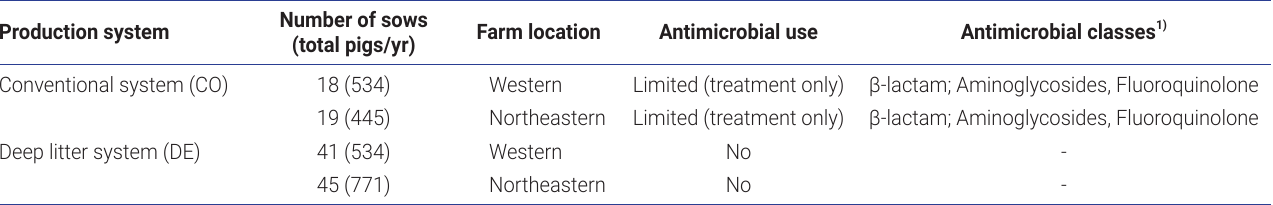
Table 1. Farm information and antimicrobial use for each farm in the current study Production